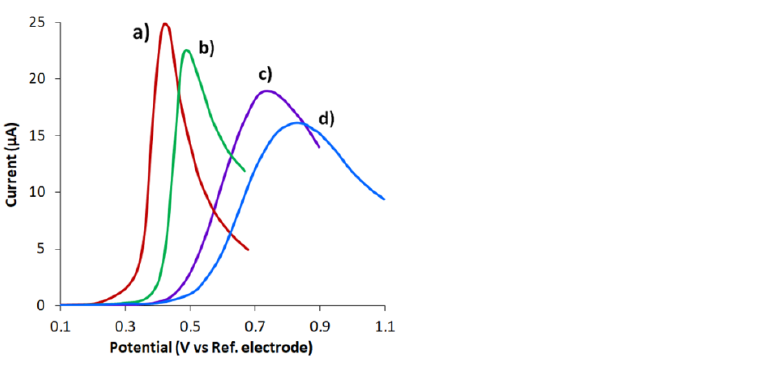
Figure 1. LS voltammograms of 0.1 mM UA for the CVE activated at 2.0 V ( a ), at 1.6 V ( b ) and at 1.0 V ( c ) and non-activated CVE ( d ) in PB pH 6.0. Potential scan rate 0.05 Vs − 1 .